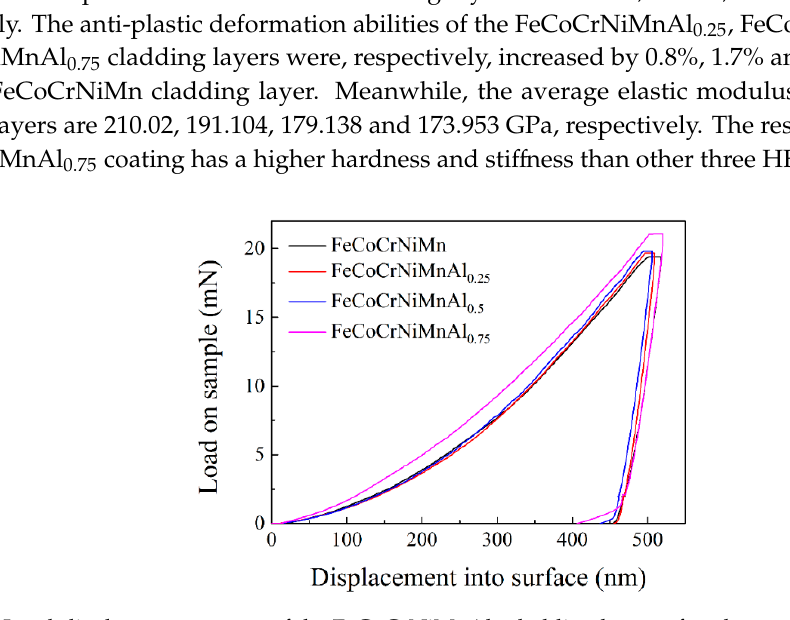
Figure 3. Friction coefficient curves and wear morphologies of the FeCoCrNiMnAl x cladding layers after 600 °C high-temperature wear tests: ( a , a1 ) x = 0; ( b , b1 ) x = 0.25; ( c , c1 ) x = 0.5; and ( d , d1 ) x = 0.75.